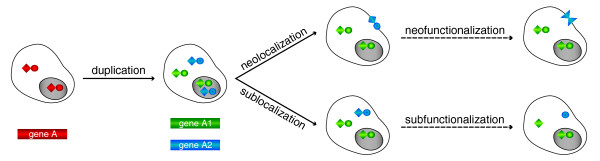
Illustration of the different evolutionary fates of (functional) duplicate genes. Each gene/protein is represented in different colors: red, ancestral, 'A'; green, duplicate copy A1; and blue, duplicate copy A2. Different shapes of proteins (circle, square, and triangle) indicate different functions. Three different subcellular localizations (nucleus, cytoplasm, and cytoplasmic membrane) are indicated in a schematic cell. We note that only the major possible scenarios are illustrated here.